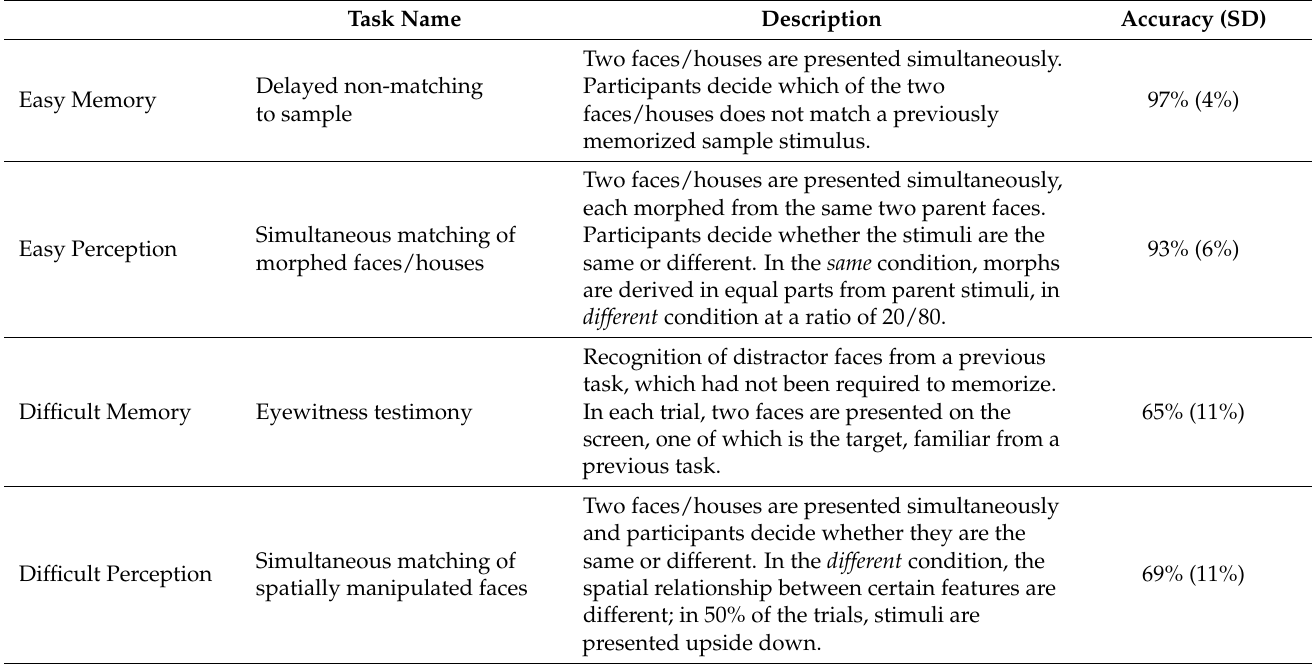
Table 1. Examples of easy and difficult face/object memory and perception tasks from Herzmann et al.